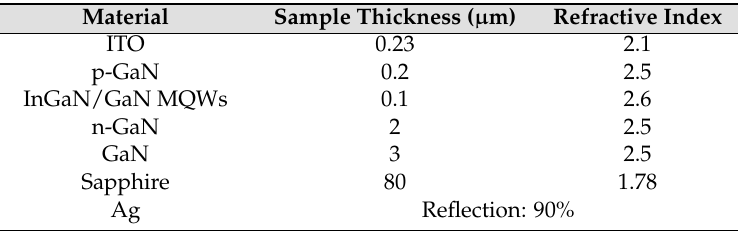
Table 1. LED material thickness and refractive indices at λ = 460 nm.